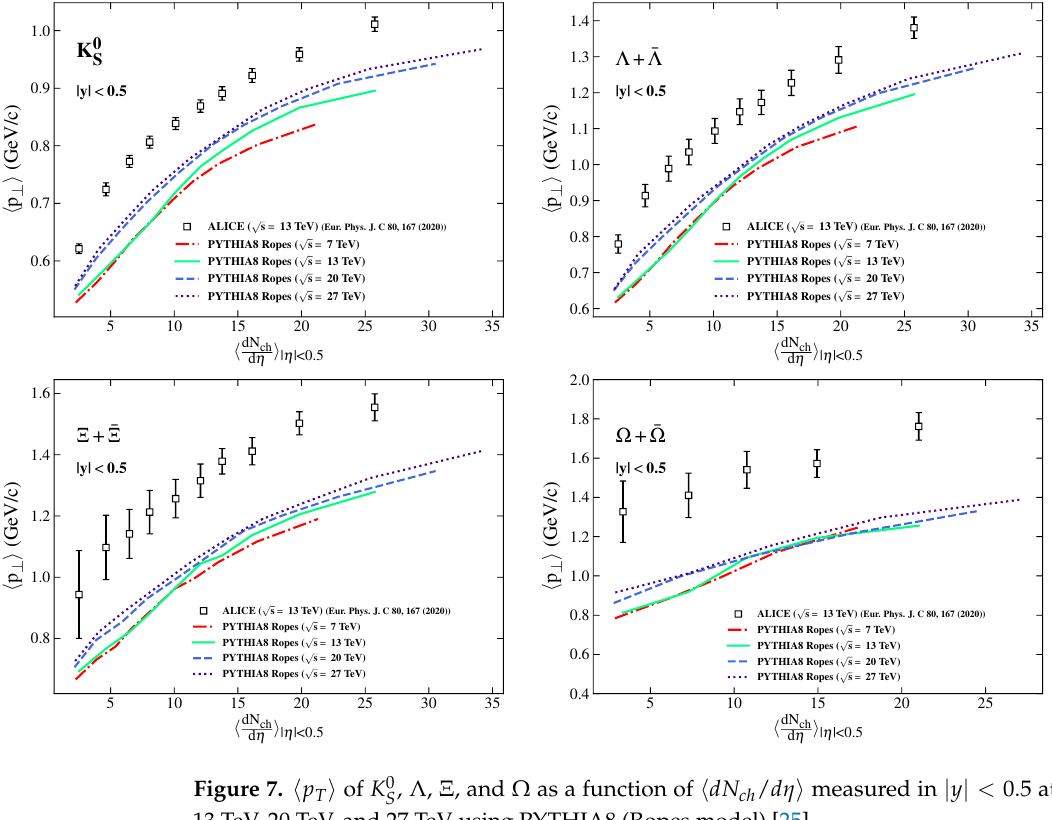
p T of K 0 , Λ , Ξ , and Ω as a function of S (cid:104) (cid:105)